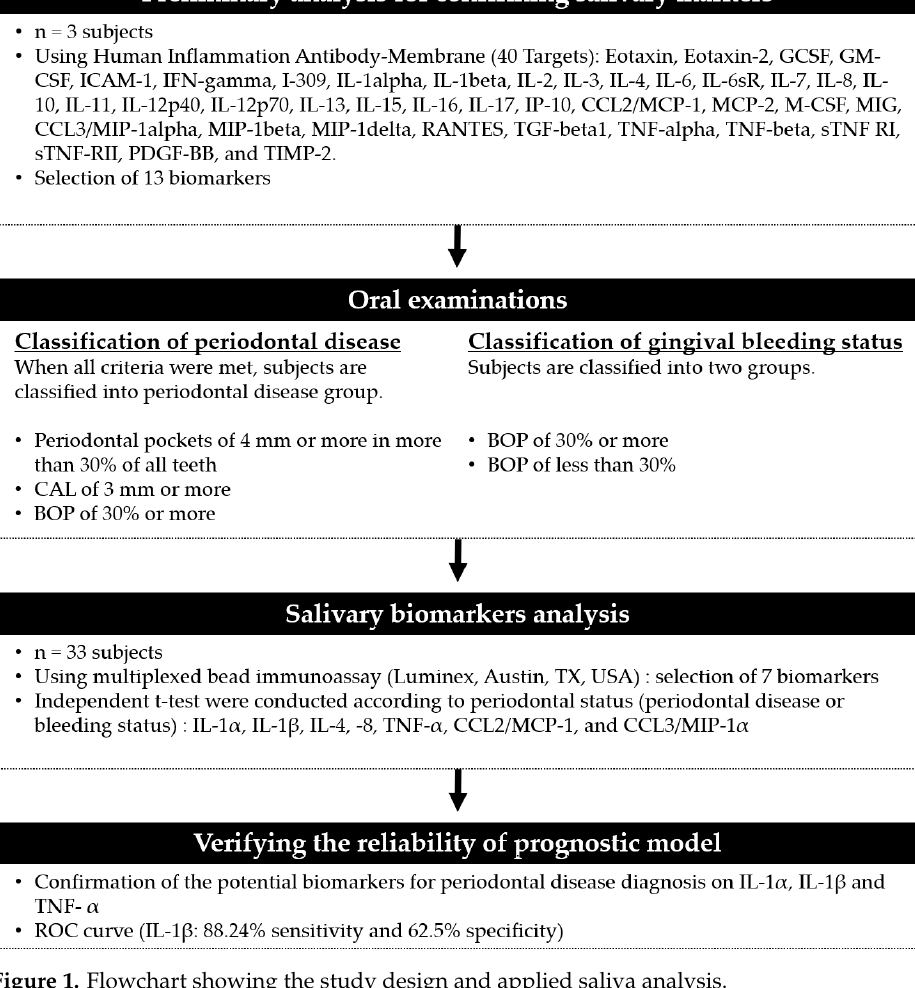
Table 2. Salivary cytokines associated with gingival bleeding Biomarkers